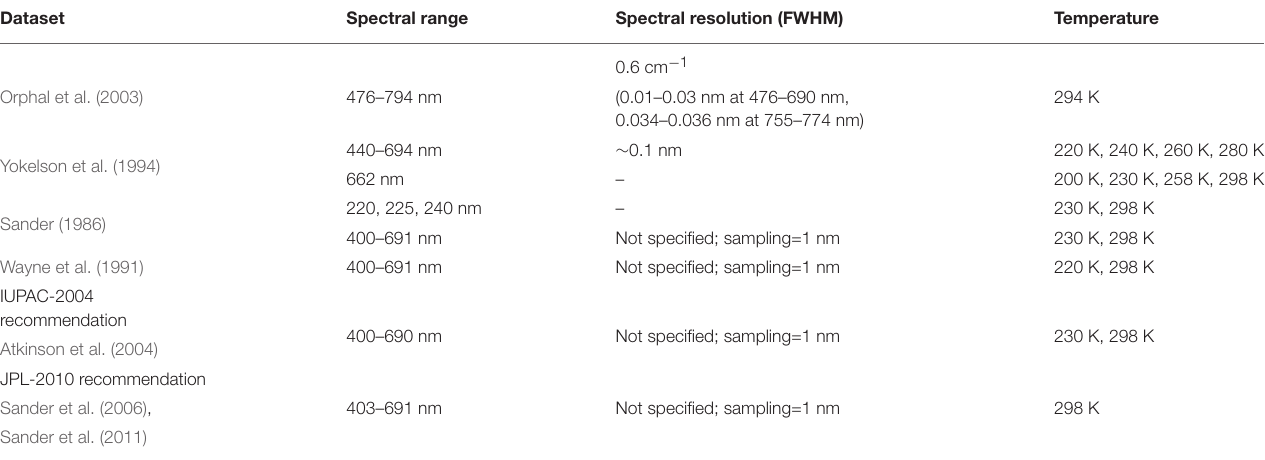
TABLE 6 | Datasets considered for the NO 3 absorption cross-section spectrum, and their